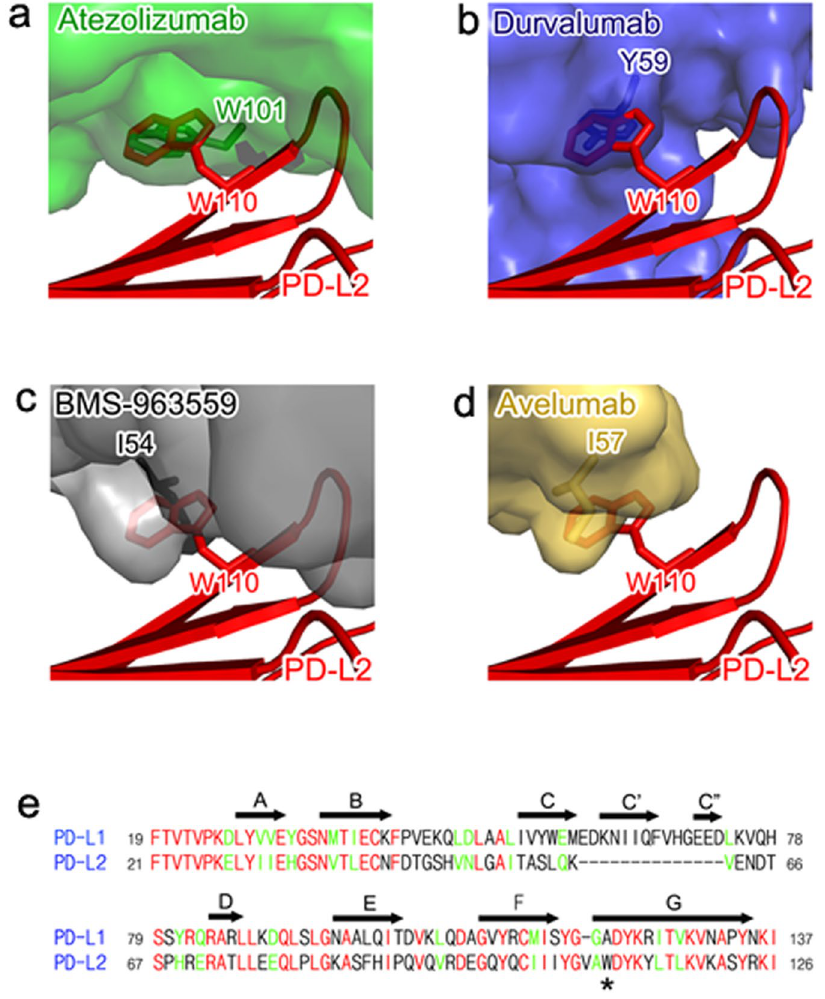
Figure 6. Structural basis for the lack of the binding of anti-PD-L1 antibodies to PD-L2. ( a ) The partially transparent surface model of atezolizumab (green) when PD-L1 of PD-L1/atezolizumab is overlaid onto PD-L2 (red, PDB code 3bov). ( b ) The surface model of durvalumab (blue) when PD-L1 of PD-L1/durvalumab is overlaid onto PD-L2. ( c ) The surface model of BMS-963559 (gray) when PD-L1 of PD-L1/BMS-963559 is overlaid onto PD-L2. ( d ) The surface model of avelumab (yellow) when PD-L1 of PD-L1/avelumab is overlaid onto PD-L2. In ( a – d ) the residues of the antibodies, which collide with W110 of PD-L2, are shown in sticks and labeled. ( e ) Structure-based sequence alignment of PD-L1 and PL-L2. The strands in PD-L1 are denoted with arrows above the sequence. W110 of PD-L2 is indicated with an asterisk. The identical and homologous residues are colored red and green,